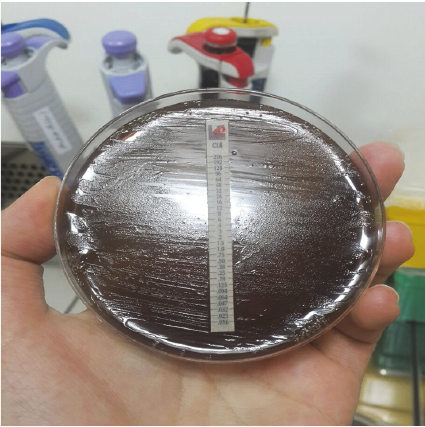
Figure 1: Successful isolation of Helicobacter pylori on Brucella agar supplemented with 5% horse